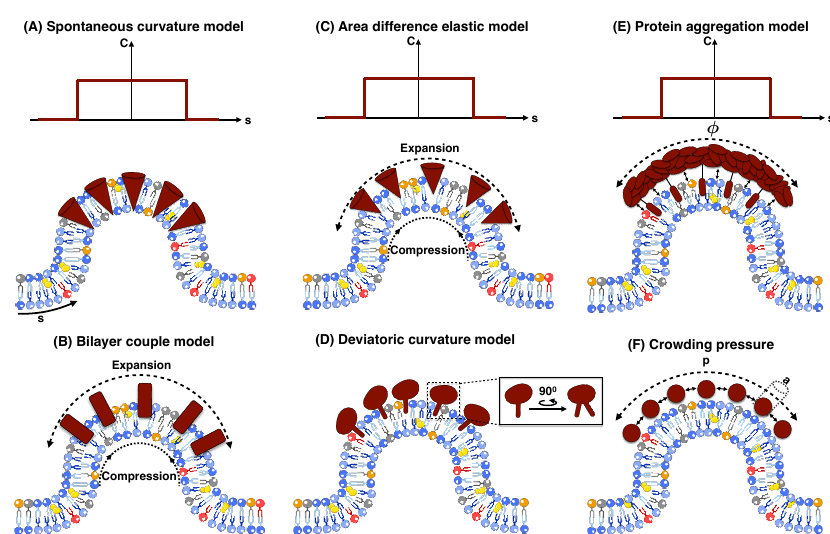
Figure 3. Cartoon models of the mechanisms of membrane curvature generation due to protein (shown in red) interactions in different continuum elastic models. ( A ) Local protein interactions with membrane produce a spontaneous curvature field. s is the arc length parameterization along the membrane and C is the induced spontaneous curvature. ( B ) The asymmetric insertion of conical proteins on one side of the membrane results in the expansion of the upper leaflet and compression of the lower leaflet. ( C ) Asymmetric insertion of proteins into the lipid bilayer induces both local spontaneous curvature and surface stresses due to membrane leaflets expansion/compression. ( D ) Rotationally non-symmetric proteins generate anisotropic curvature. ( E ) Aggregated proteins on the membrane surface create a spontaneous curvature field and also have entropic interactions with the membrane. Here, φ represents the relative density of the accumulated proteins. ( F ) The induced pressure (p) by crowding proteins drives membrane bending. a is the surface area occupied by one